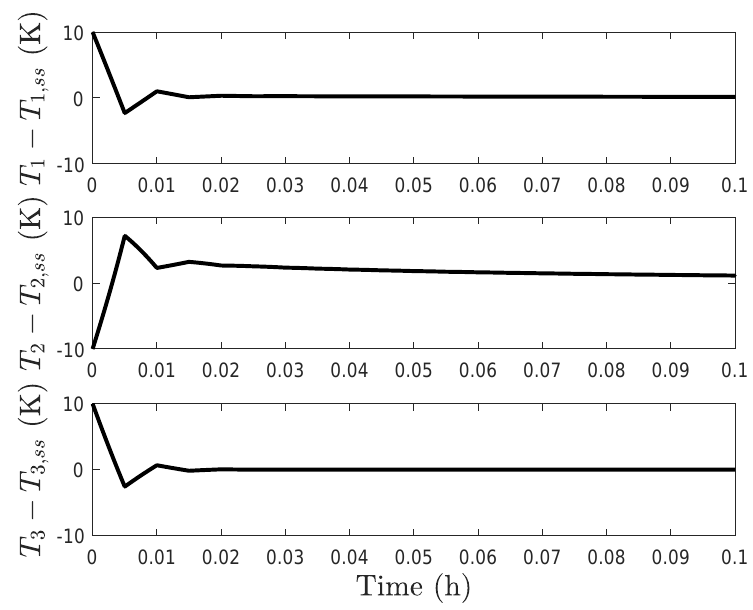
Figure 1. T 1 , T 2 , and T 3 over 0.1 h of operation for the 2 CSTR-flash drum process under an MPC which drives the closed-loop state to the unstable steady-state.